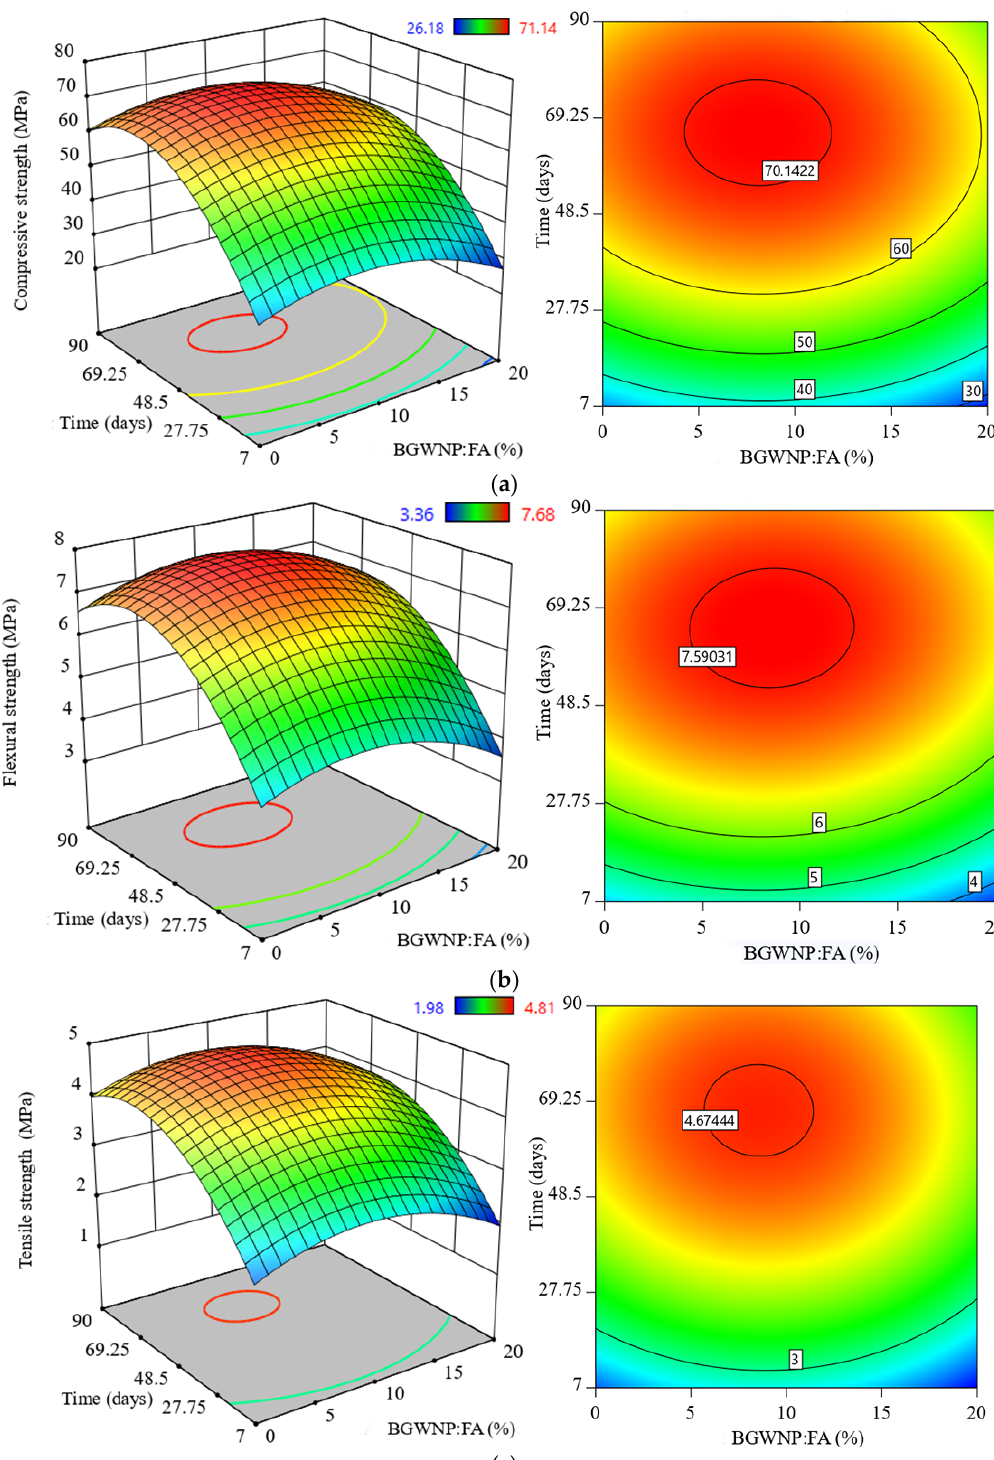
Figure 9. Evolution of ( a ) compressive strength, ( b ) flexural strength, and ( c ) tensile strength of FA-GBFS-based AAM with different replacement percentages of fly ash by BGWNP.